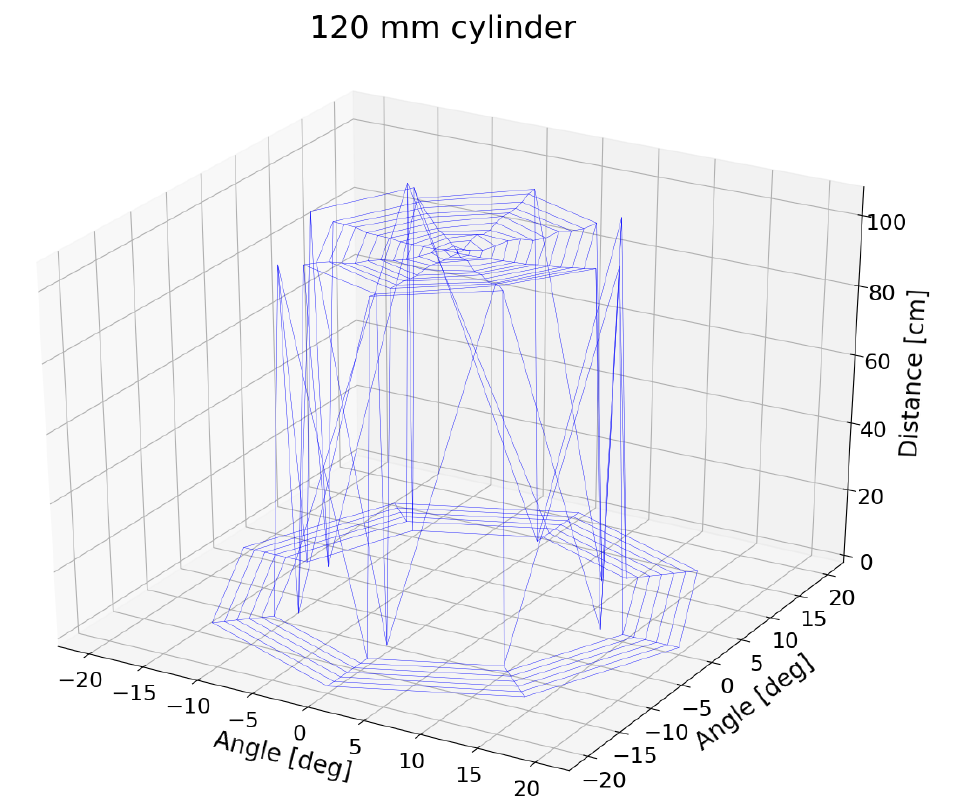
Figure 10. HC-SR04 detection of the 120 mm cylinder. For wrist angles of − 45, 0, 45, and 90 degrees of the robotic arm, an scan of steps of one degree around z-axis was